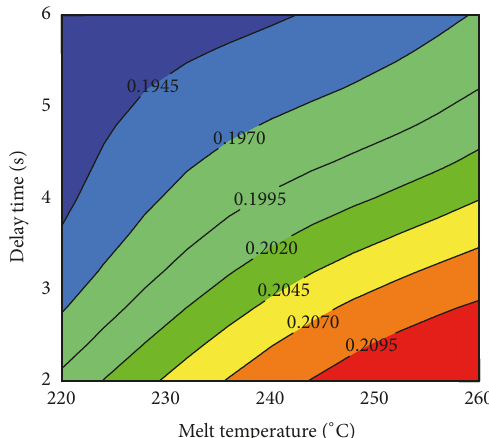
Figure 8: Short fiber orientation of RWT in the melt and water filling stages.